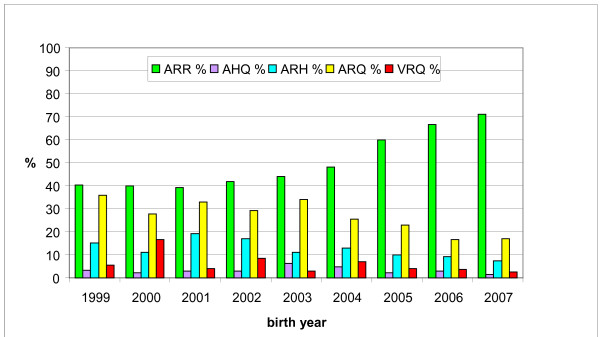
Farm survey PrP allele frequencies. Mean PrP allele frequencies of all sheep from the 168 farms sampled in this study divided by birth cohort.